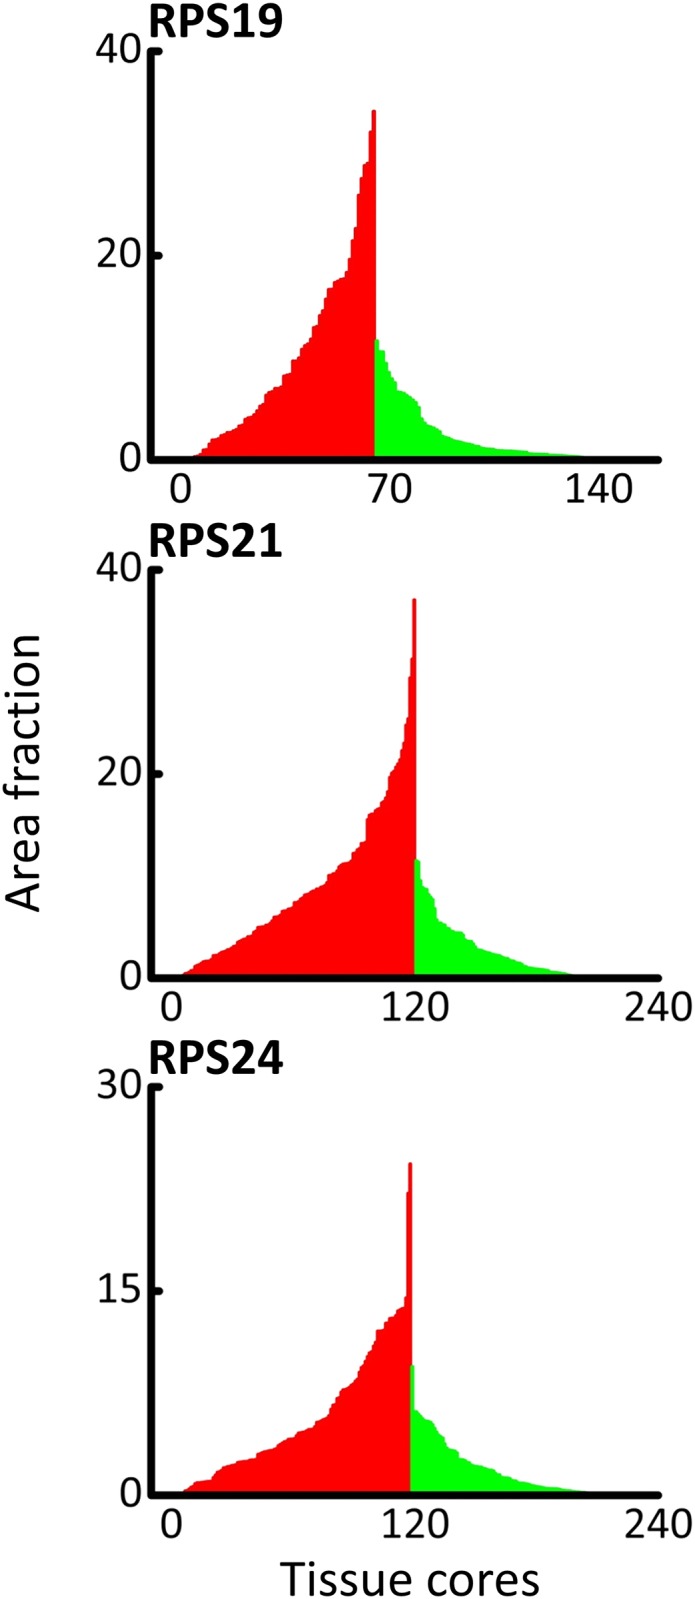
Expression analysis of Ox-DAB signal in prostate tissue.Area fraction (AF) was calculated by dividing the amount of signal, in pixels, by the total number of pixels representing tissue per an unbiased signal quantification protocol (see Materials and methods- Signal quantification). Each bar is representative of the AF of a single TA core. Malignant cores are represented by red and non-malignant cores are represented by green. A significant difference between AUC values was seen for each protein that was tested (p<0.0001).